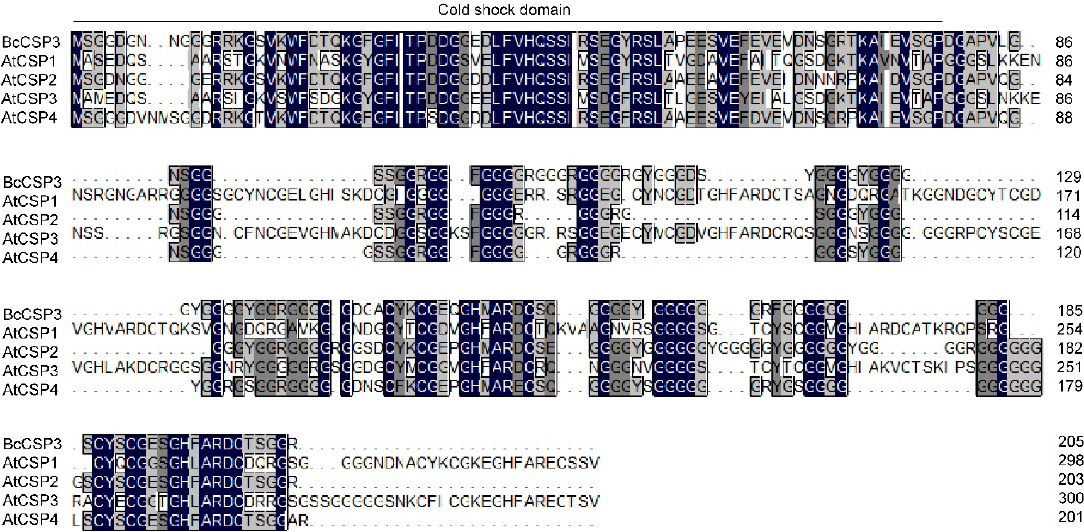
Figure 3. Tertiary structure prediction of the BcCSP3 protein. Random coil, extended strand and beta turn make up most of the main body.